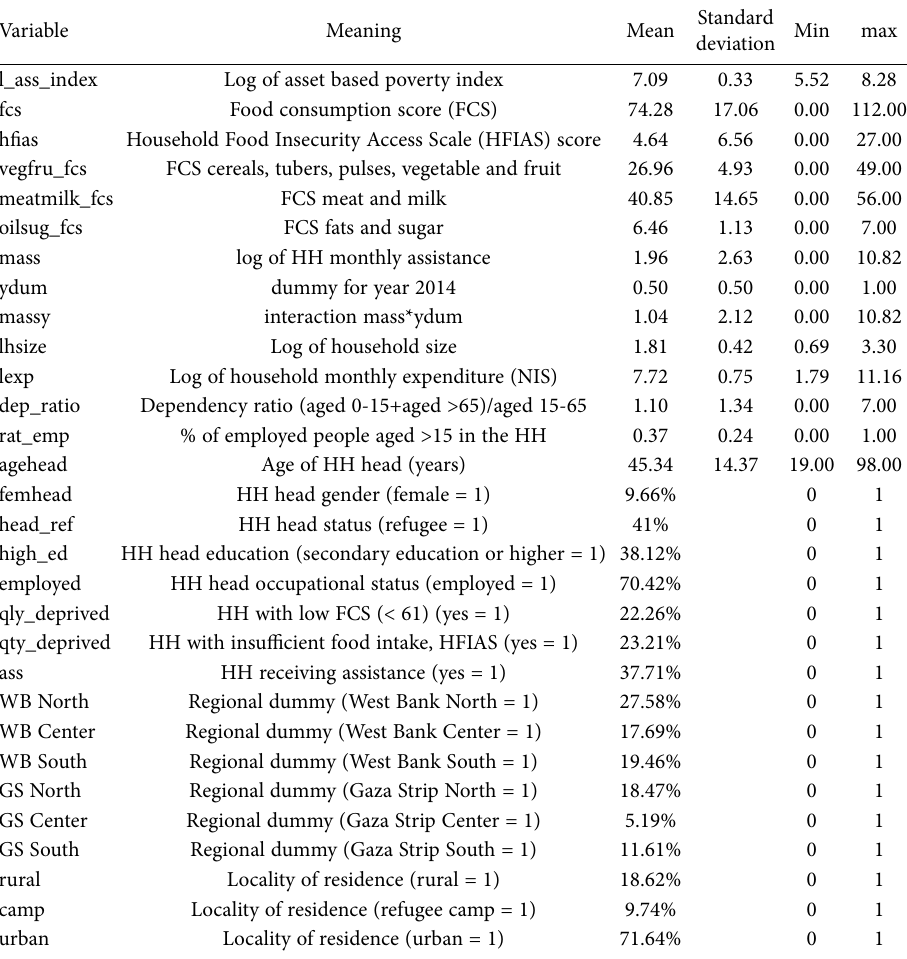
Table 8. Summary statistics of key